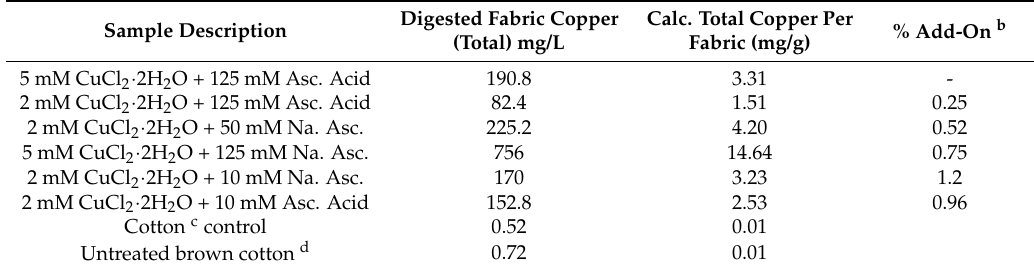
Table 1. Total copper concentration of cotton samples determined by inductively coupled plasma-atomic emission spectrometry a (ICP-AES).